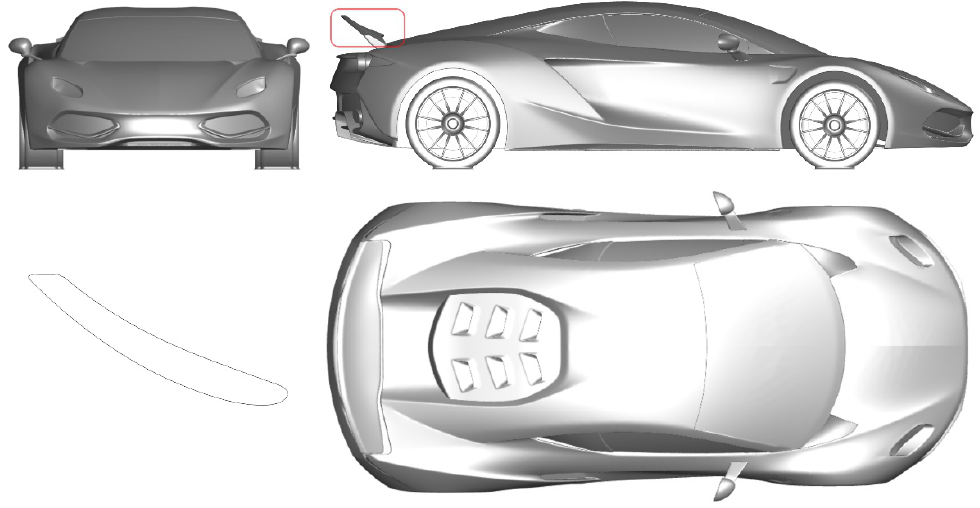
Figure 5. The geometry of the analyzed car and cross-section of the spoiler.